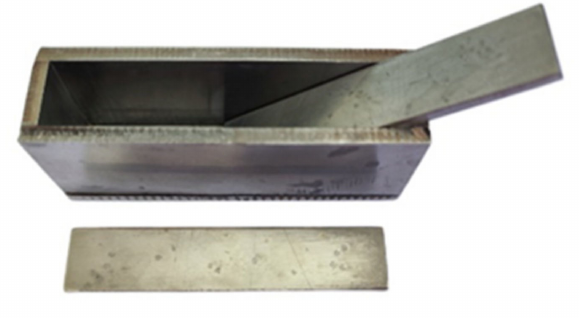
Figure 5. Specimen preparation